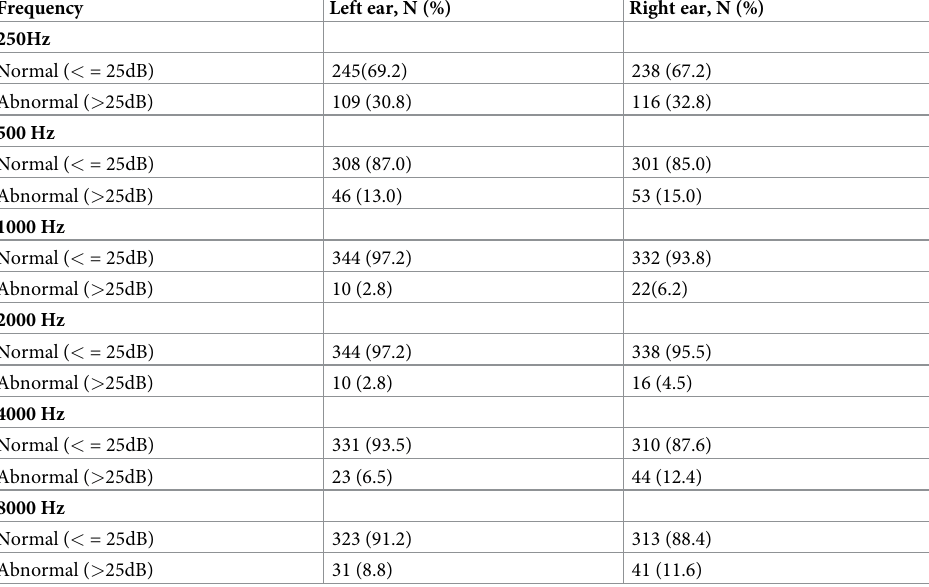
Table 3. OHL at different